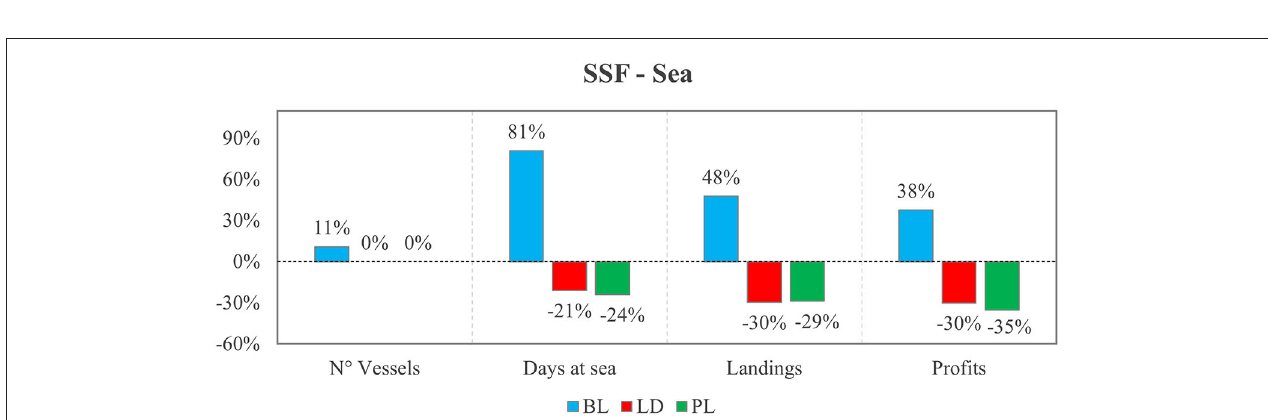
FIGURE 7 | Percentage differences between 2019 and 2020 during the three periods (BL: before lockdown, LD: lockdown, and PL: post-lockdown) considering the number of active vessels, the days at sea, landings, and profits of the Chioggia SSF fleet.